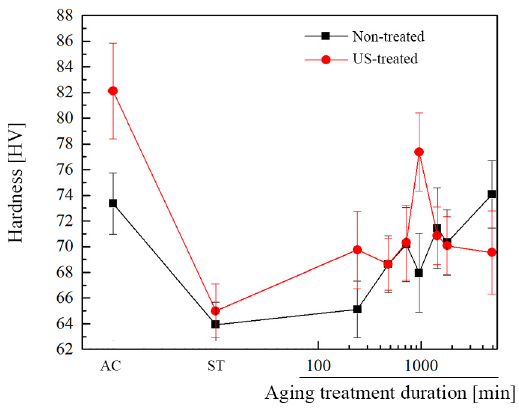
Figure 5. Average Vickers hardness of the non- and US-treated samples during arti fi cial aging.